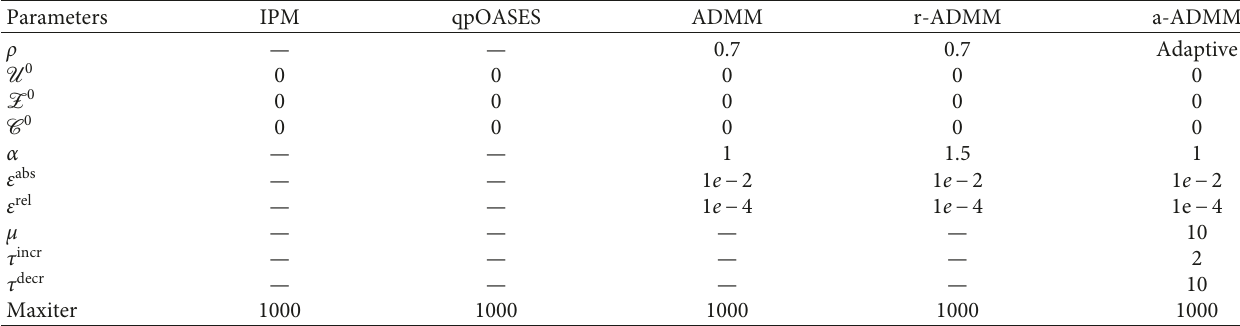
Table 1: List of algorithmic